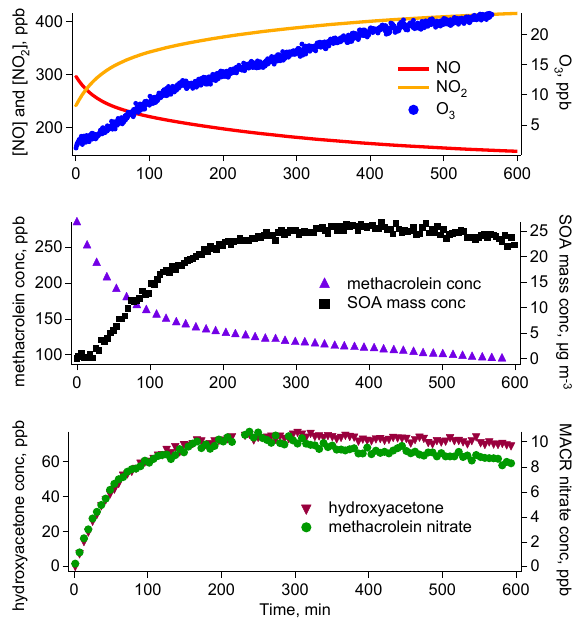
Fig. 1. Concentration profiles of gas-phase species during a typical methacrolein/high-NO experiment (16/07/09). In this experiment, additional NO 2 was injected prior to irradiation. Concentrations of NO and NO 2 shown here are calculated from a photochemical model (see Appendix).